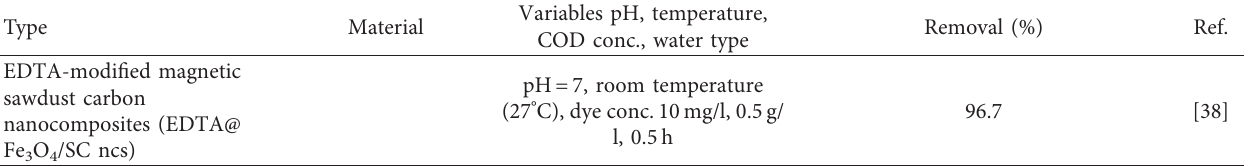
Table 4: Comparison between the present study and previous studies for the biosorption of the brilliant green dye from point of view of the operating